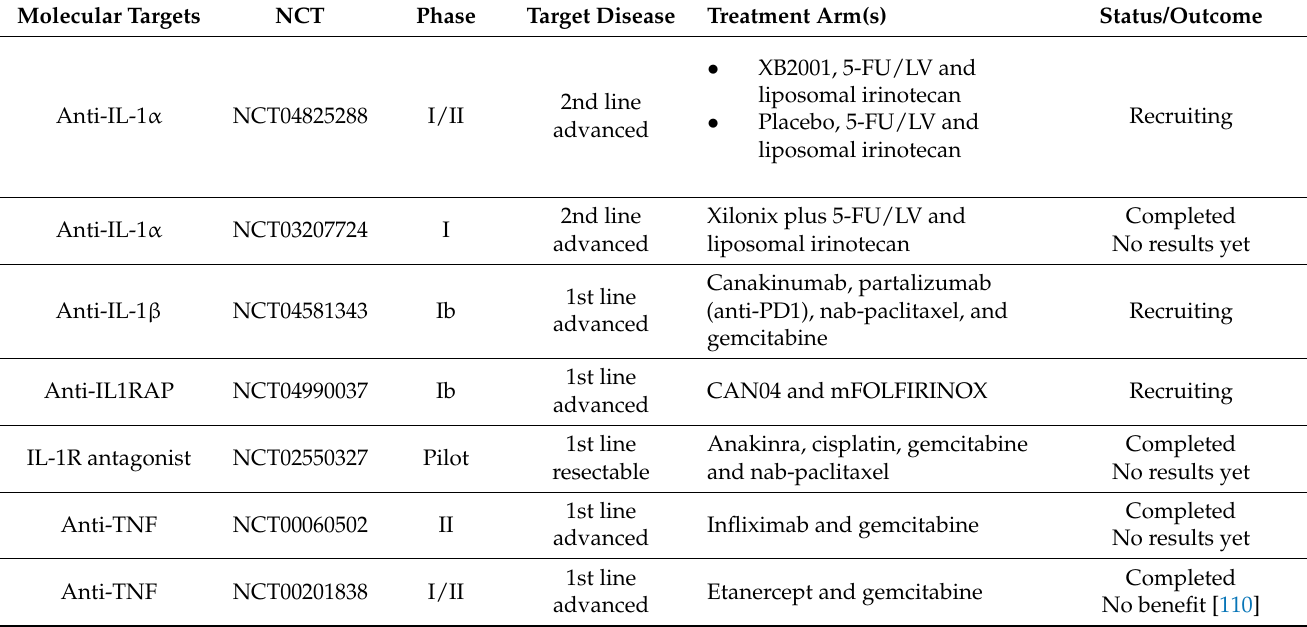
Table 1. Summary of selected past and recent clinical trials targeting inflammatory pathways in